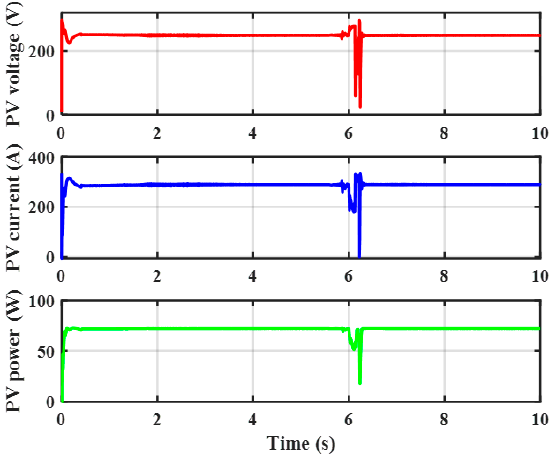
Figure 22. PV panel parameters with LLLG fault.